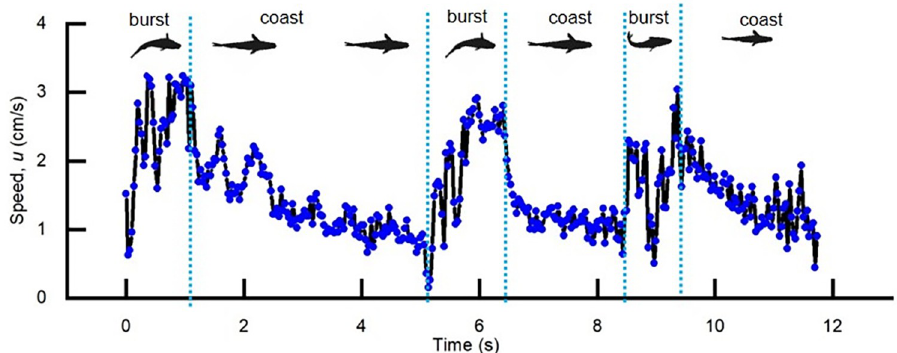
Fig 6. Swimming speed. Swimming speed ( u ) versus time taken from a series of images during Experiment 2. This illustrates a burst-and-coast swimming